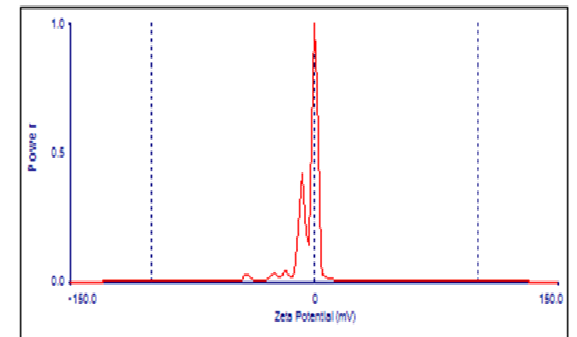
Figure, 4: Show the Zeta potential of ZnO nanopartical.